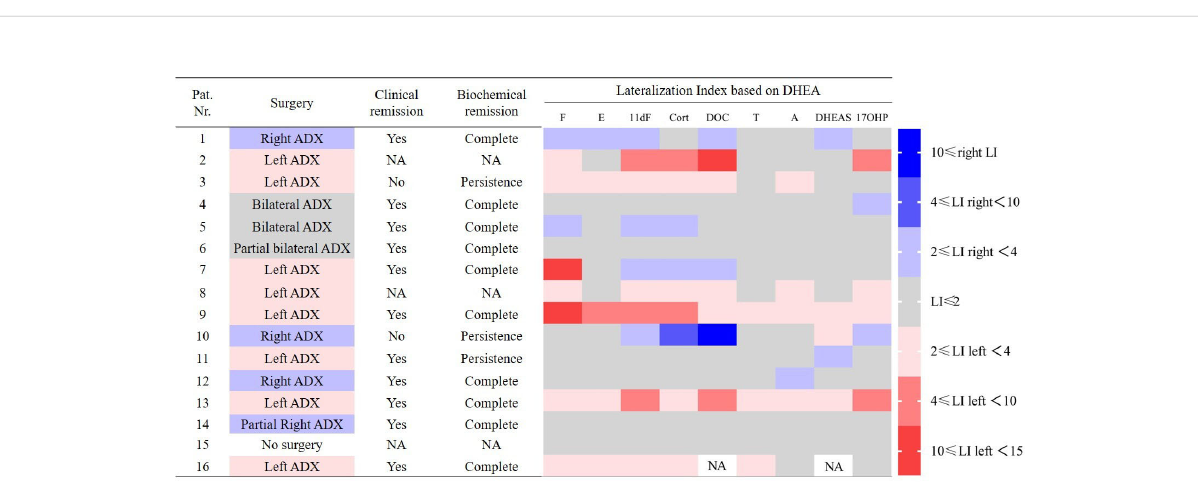
FIGURE 3 Comparison between lateralization index (LI), surgery and outcome in patients with PBMAH. Steroids below LLOQ or dectection were excluded in the fi gure. Pat. No. 17 was excluded because offailed adrenal vein cannulation. NA, not available; ADX, adrenalectomy; F, cortisol; E, cortisone; 11dF, 11-deoxycortisol; Cort, corticosterone; DOC, 11-deoxycorticosterone; T, testosterone; A, androstenedione; 17OHP,